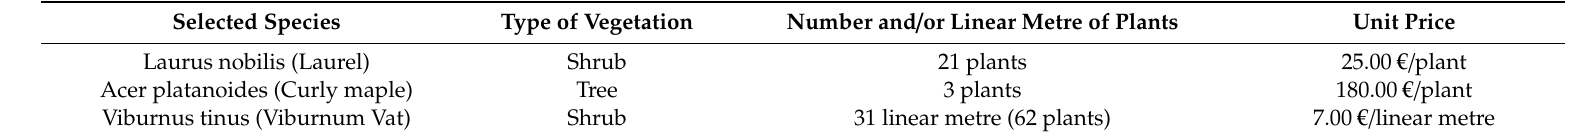
Table 6. Selected arboreal / arbustive species: number of units to be planted and corresponding unit